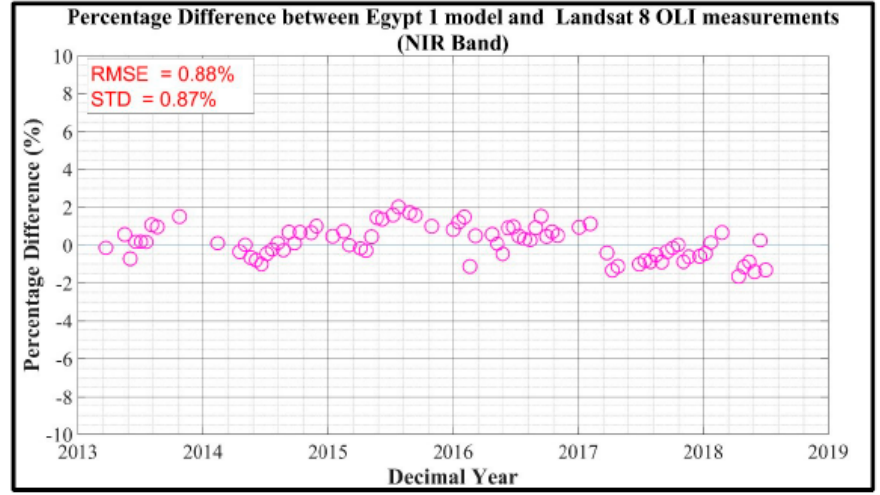
Figure 3. Percentage di ff erence of Egypt 1 model and Landsat 8 OLI observation [49].